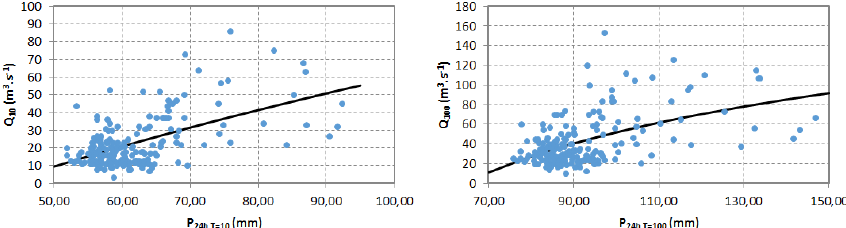
Figure 3. Relationship between catchment average maximum 24h precipitation total and peak discharge values for T = 10 years (left panel) and T = 100 years (right panel) with fitted lines following Eq.